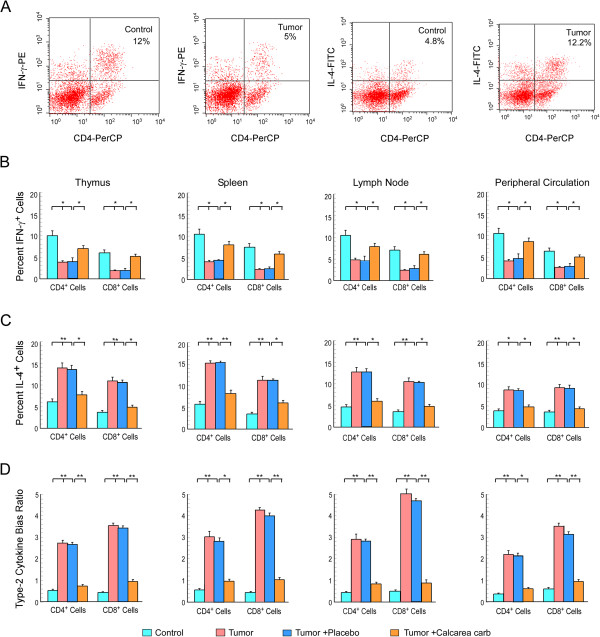
Calcarea carbonica normalizes cytokine-producing effector T cell populations in tumor-bearing host. (A) Typical flow cytometric patterns for IFN-γ and IL-4 producing CD4+ T cells in draining lymph nodes of mice. Graphical representation of flow cytometric data of intracellular IFN-γ (B), IL-4 (C) and type-2 cytokine bias ratio (D) in CD4+/CD8+ T cells of thymus, spleen, lymph node and peripheral circulation of untreated or placebo-/calcarea carbonica-treated tumor-bearing and normal mice at 21 days of drug administration. Values are mean ±SEM of five independent experiments. *p < 0.05 and **p < 0.001 when compared with respective non-tumor/tumor bearing control sets and tumor bearing placebo/drug-treated sets.